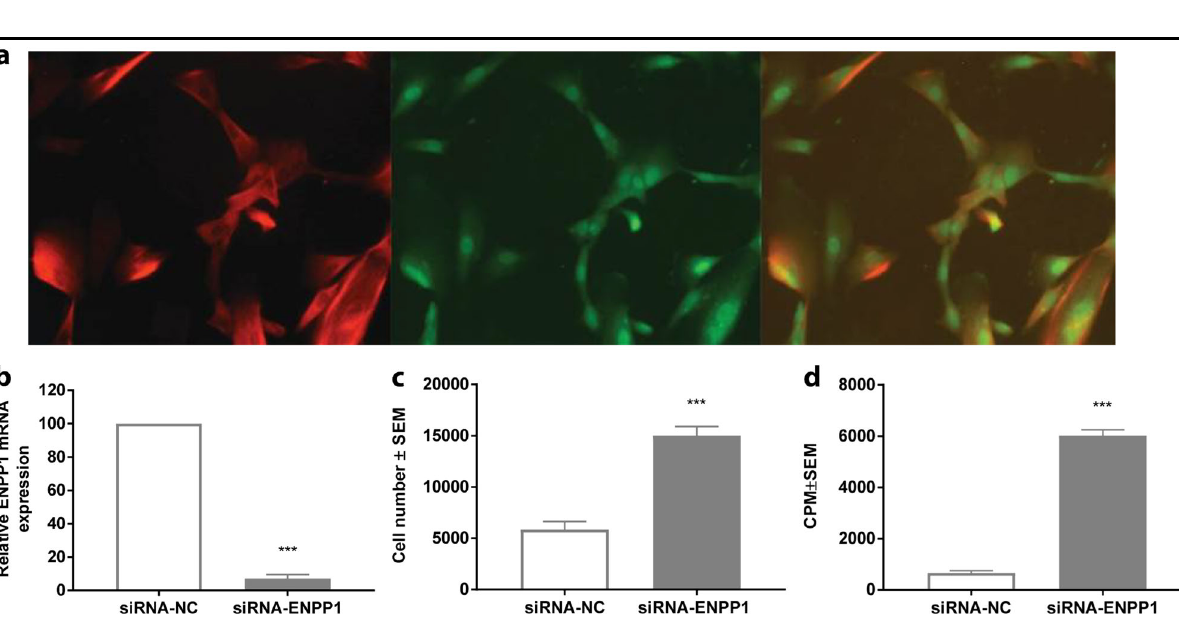
Fig. 2 Silencing of ENPP1 by siRNA in hiPSC-derived VSMCs results in a reduction of ENPP1 RNA expression and an increase in hiPSC- derived VSMCs proliferation. SMC markers calponin ( fi rst panel) and SM-MHC11 (second panel) con fi rmed the SMC phenotype of hiPSC-derived VSMCs ( a ). hiPSC-derived VSMCs were transfected overnight with ENPP1 siRNA or control siRNA, followed by 24-h starvation in 0.25% FBS. Then, the cells were cultured in basal media. ENPP1 RNA expression ( b ) and hiPSC-derived VSMCs cell number ( c ), and proliferation ( d ) were investigated. b , c Values are presented as the mean ± SEM, n = 4; *** p < 0.001 vs. control nontargeting siRNA transfected cells. d Cell proliferation was evaluated by [ 3 H] thymidine uptake. [ 3 H]thymidine was added in the last 18 h of culture. The results are expressed as the CPM ± SEM, n = 4. *** p < 0.001 vs. control nontargeting siRNA transfected cells (Student ’ s t test, unpaired two-group testing for